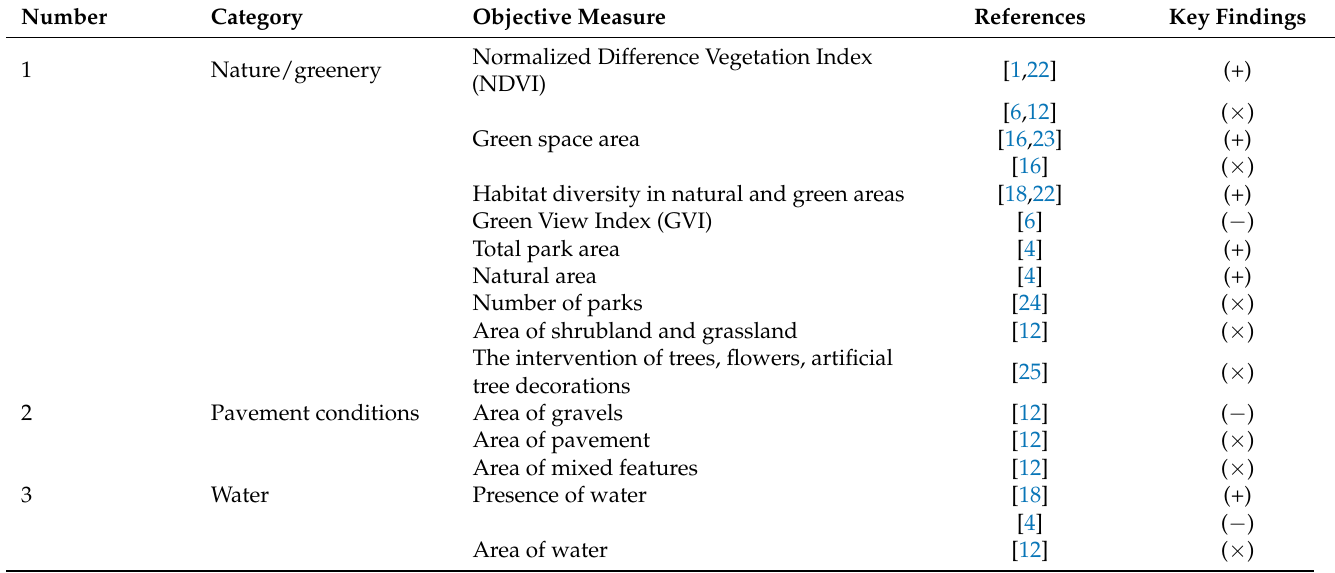
Table 2. Summary of the significance of objective measures of landscape